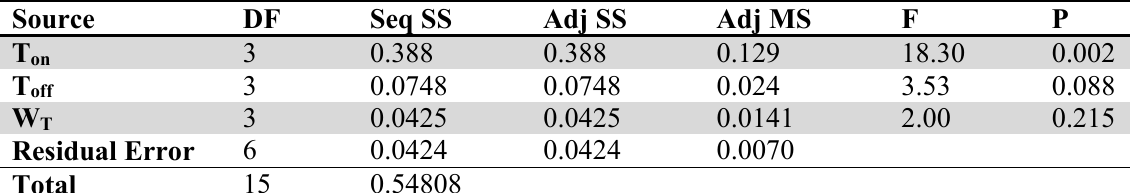
Analysis of Variance for